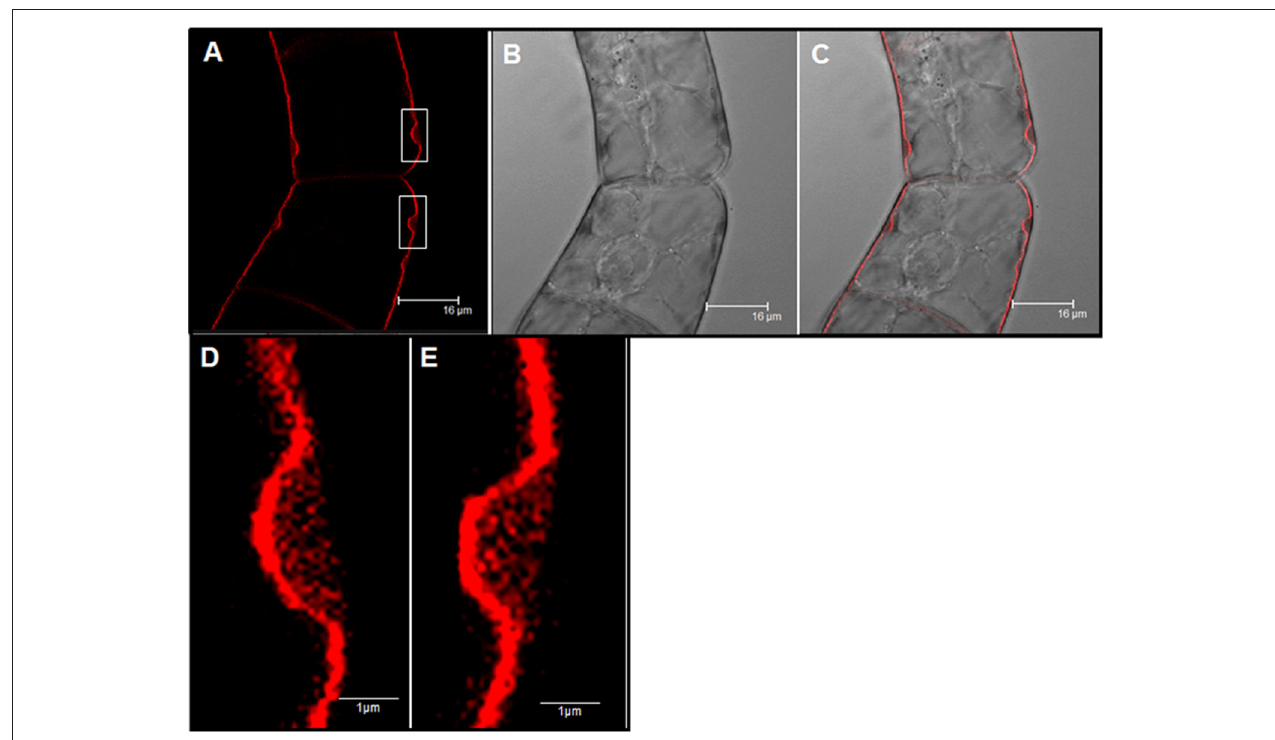
FIGURE 6 | Cellular localization by fluorescence microscopy of Yariv precipitates on samples of control tobacco BY-2 cells treated with 100 µ M Yariv reagent for 24h. (A) FM4-64 fluorescence images (Yariv precipitates, white squares). (B) DIC image. (C) Overlapping of DIC and fluorescence images. (D,E) A high magnification from image (A) of Yariv precipitates showing a coil